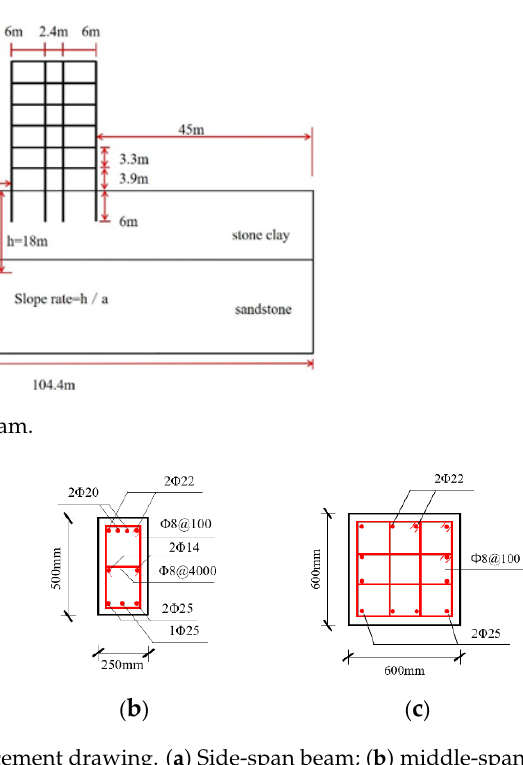
Figure 4. Section reinforcement drawing. ( a ) Side-span beam; ( b ) middle-span beam; ( c ) column.